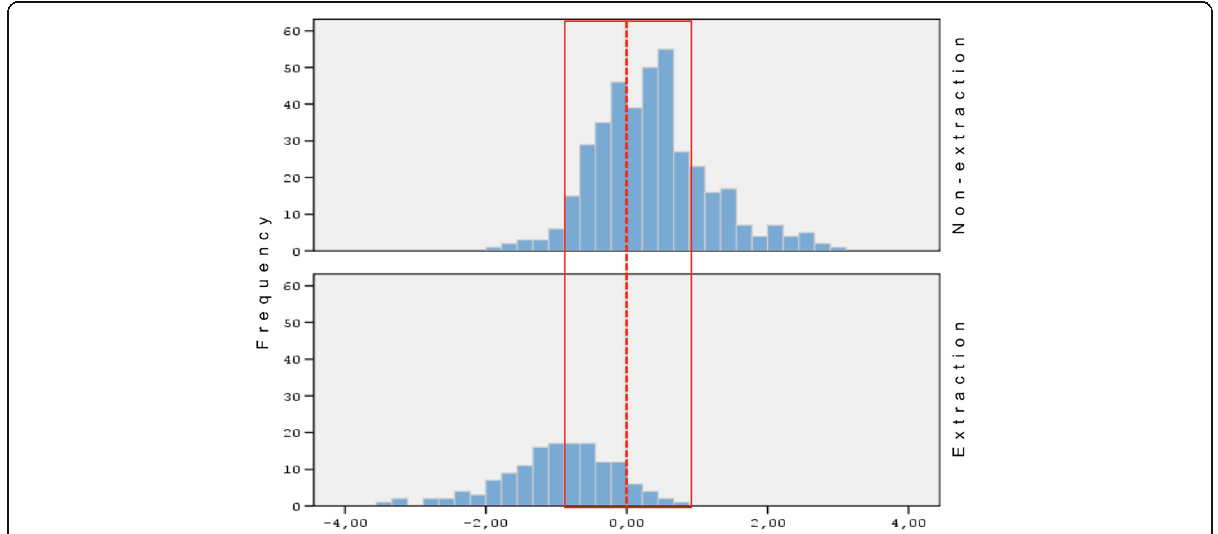
Fig. 1 Histogram of Fisher ’ s discriminant scores distribution for the extraction and the non-extraction groups of patients. The red vertical line indicates the optimal cutoff point at 0, and the red dashed vertical lines indicate the range within 1 standard deviation (0.94) that the borderline sample was